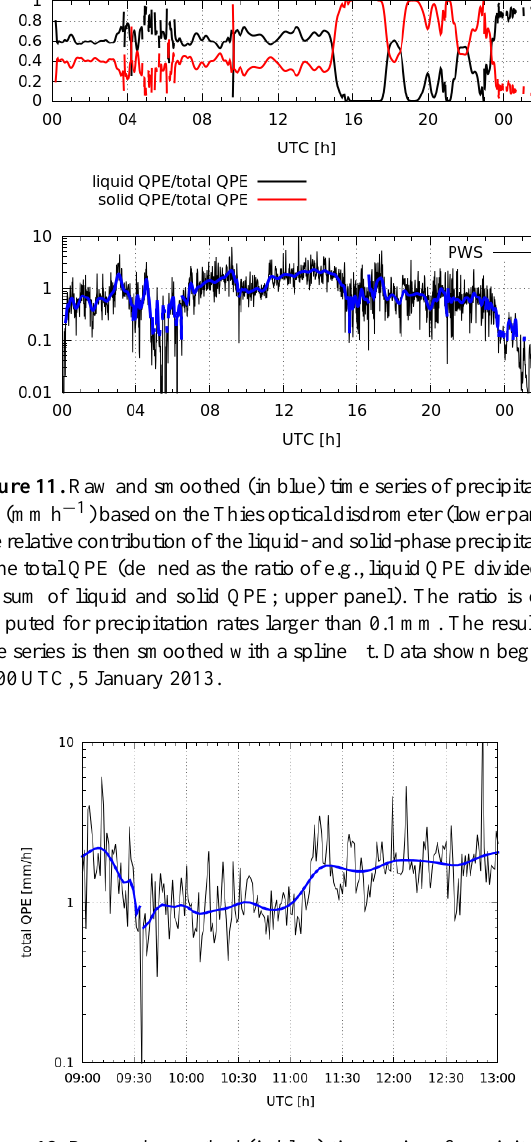
Figure 12. Raw and smoothed (in blue) time series of precipitation rate (mmh − 1 ) based on the Thies optical disdrometer. Zoom in to the time period with the passage of the mesoscale event (between about 11:00 and 12:00UTC). Data shown are from 5 January